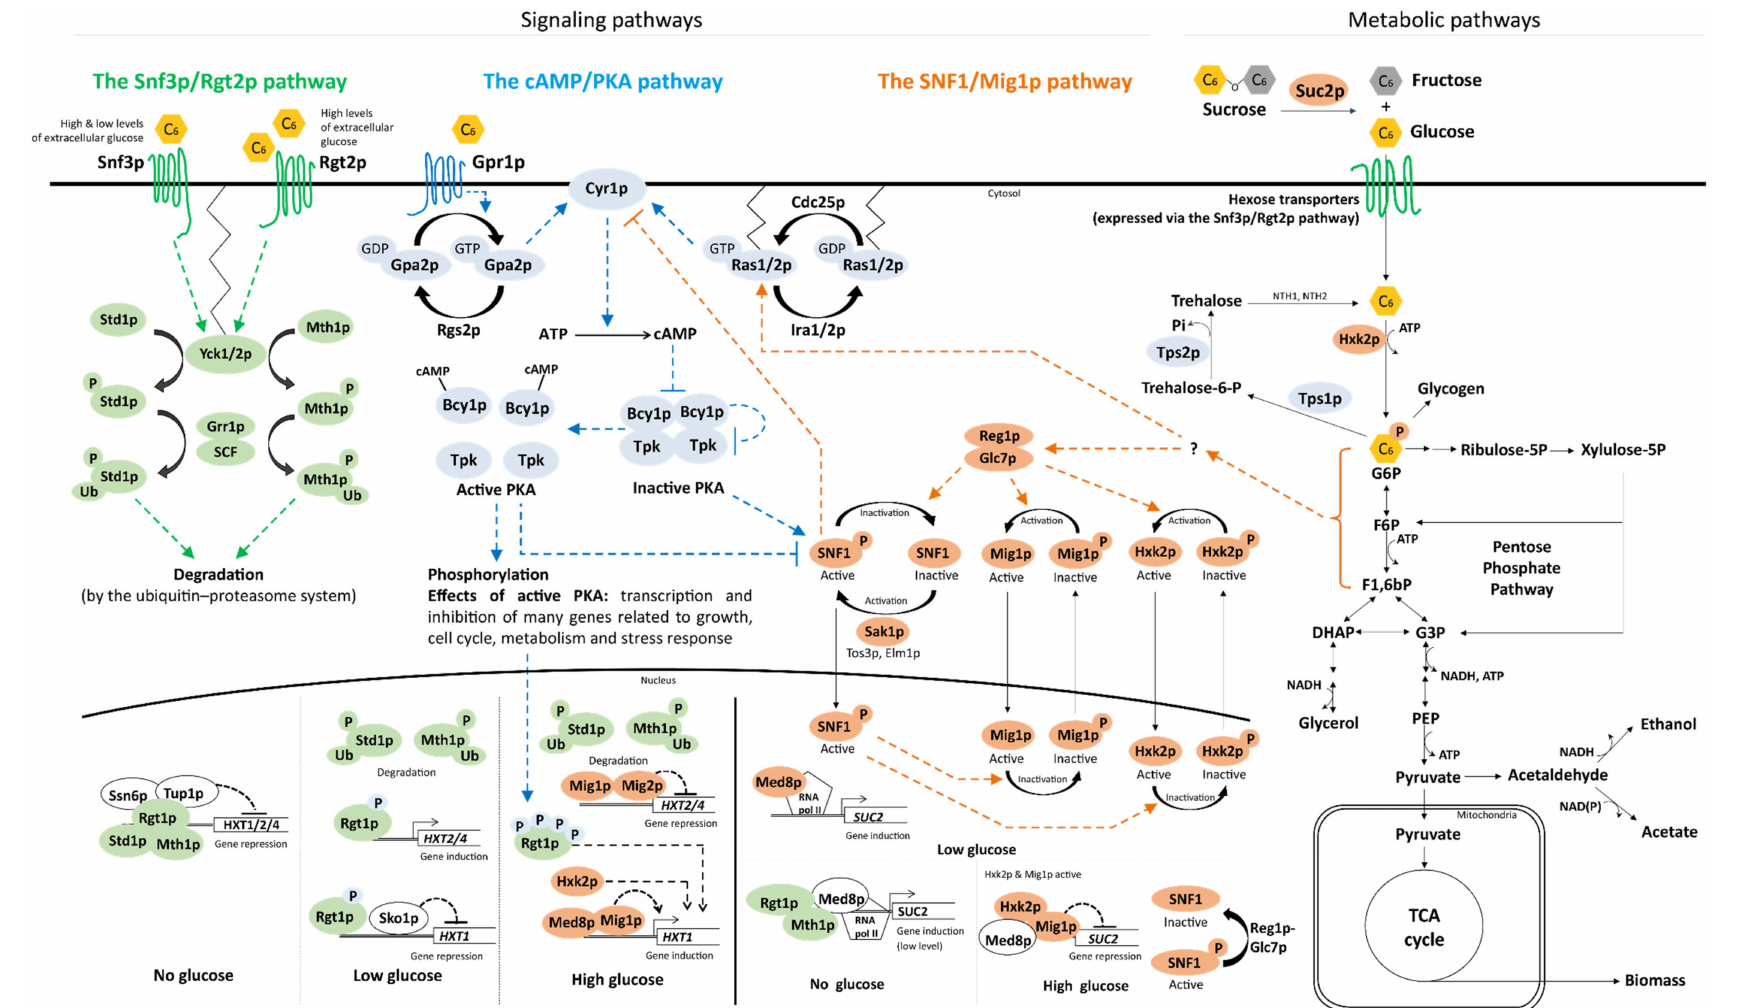
Figure 2. Overview of the key signal transduction events in three major sugar signaling pathways (Snf3p/Rgt2p, cAMP/PKA, SNF1/Mig1p) in S. cerevisiae and their connection to D -glucose and D -xylose metabolism. The XR/XDH and XI pathways are also shown in detail, whereas only the major connections are shown for the Weimberg and Dahms pathways. Three different carbon source availability cases are depicted: no D -glucose, low D -glucose and high D -glucose concentrations. Colored shapes: proteins under the control of the